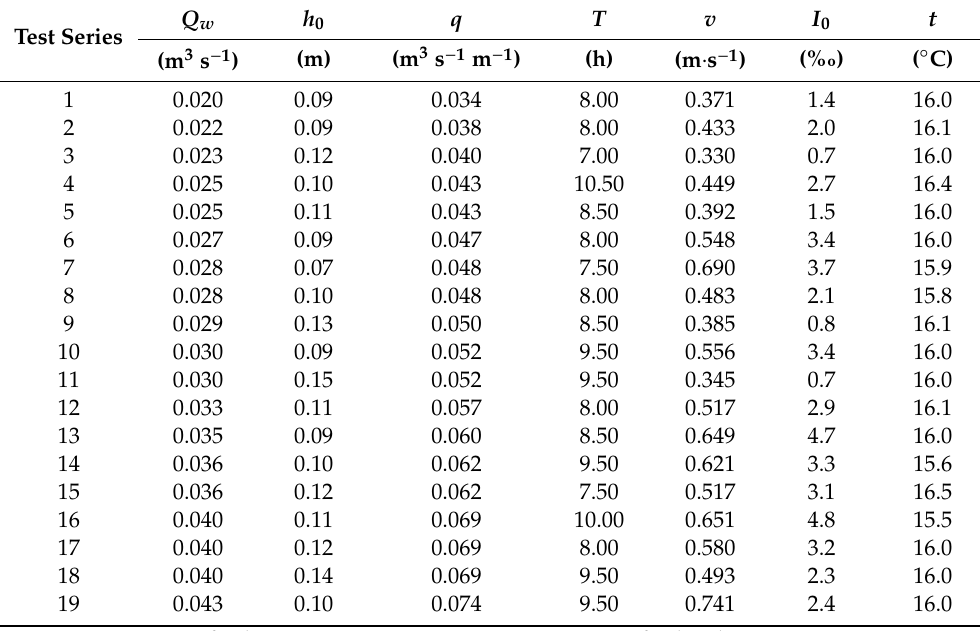
Table 1. Main parameters of test series.